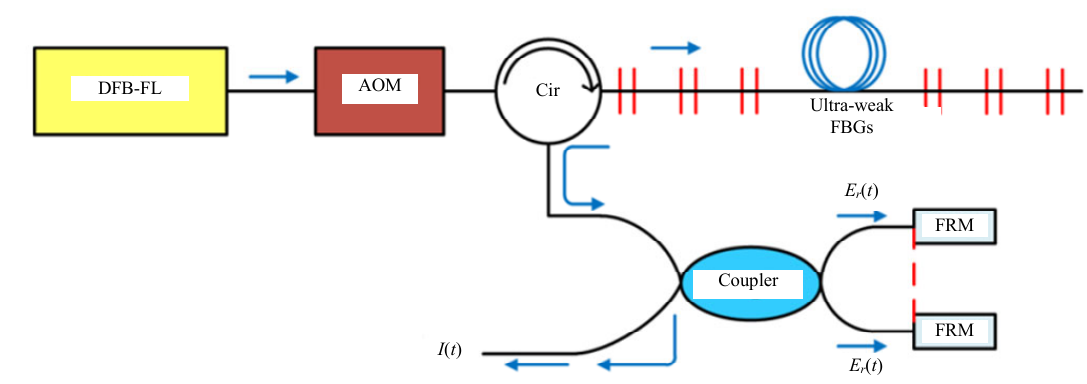
Fig. 9 Schematic configuration of the  -OTDR interferometer based on the UWFBG array